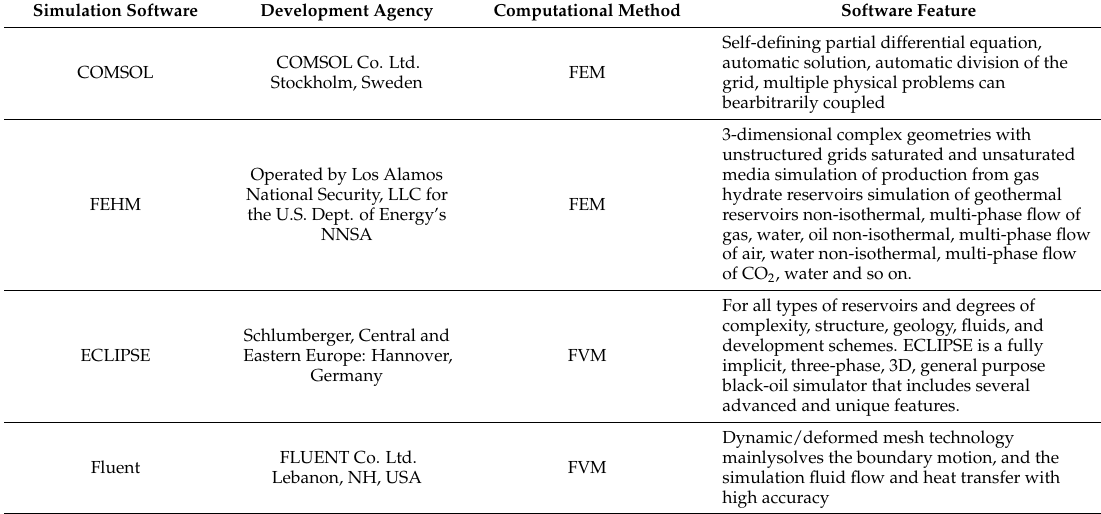
Table 1. Comparison of numerical simulation software for EGS